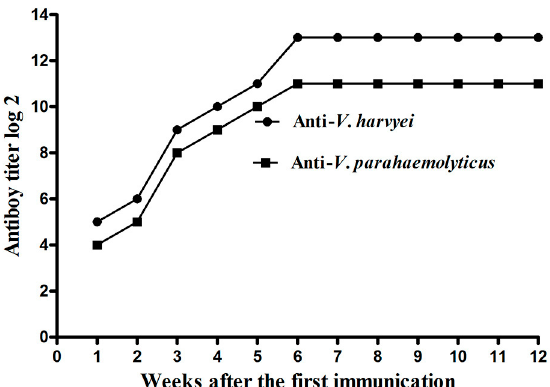
Figure 2. The titer of anti- V. harveyi and anti- V. parahaemolyticus IgY in the egg yolk detected by enzyme-linked immunosorbent assay (ELISA).